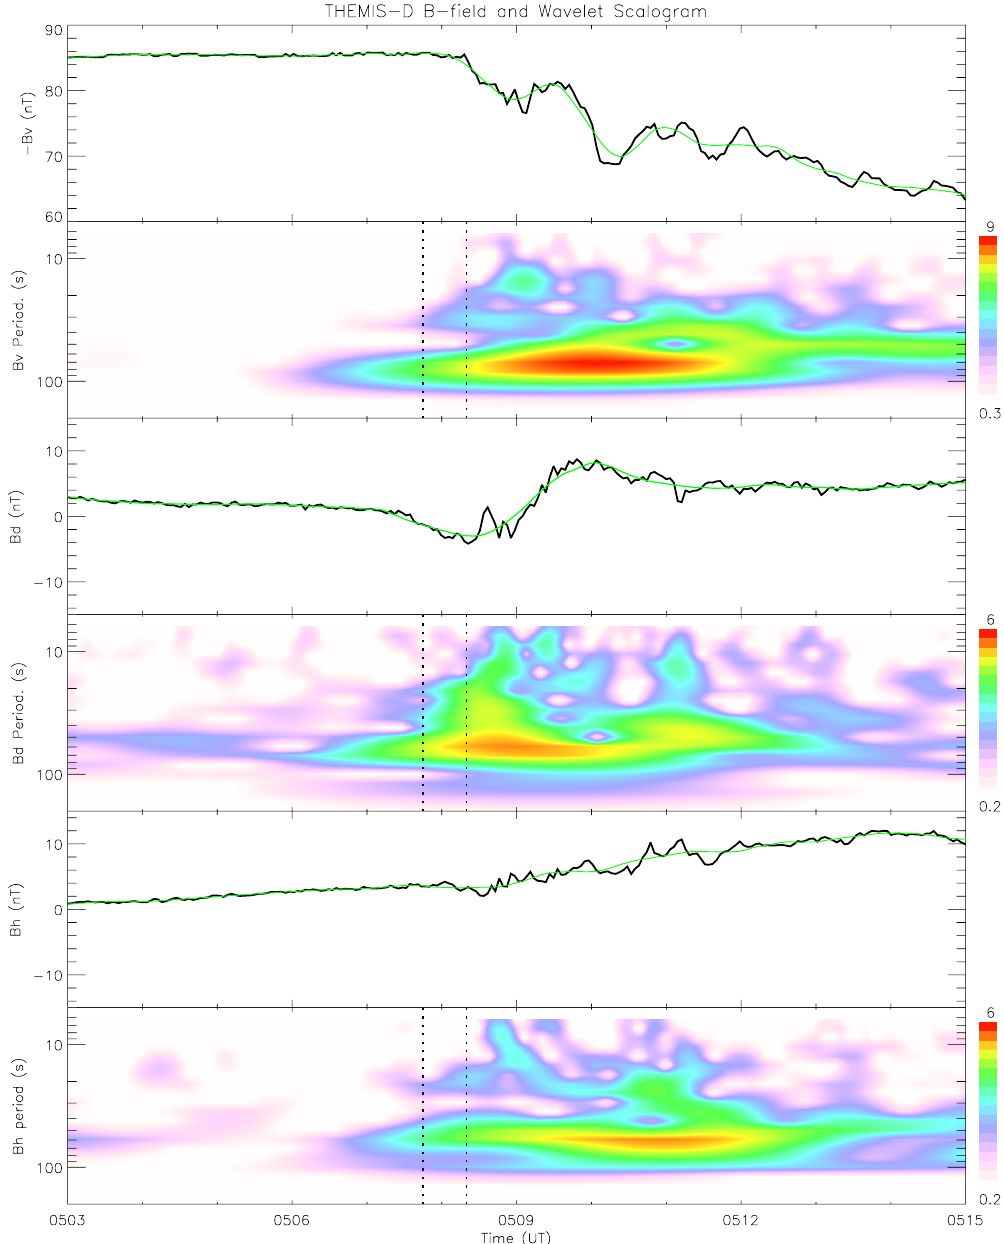
Fig. 2. The figure is grouped into B v , B d and B h components observed on TH-D. In each group the upper plot shows the observed magnetic field component (black), the “ambient” field variation (green) obtained from Savitzky-Golay smoothing. The bottom panel shows the wavelet scalogram of the magnetic field components. Two vertical lines indicate the EP onset time and the local CD onset time,